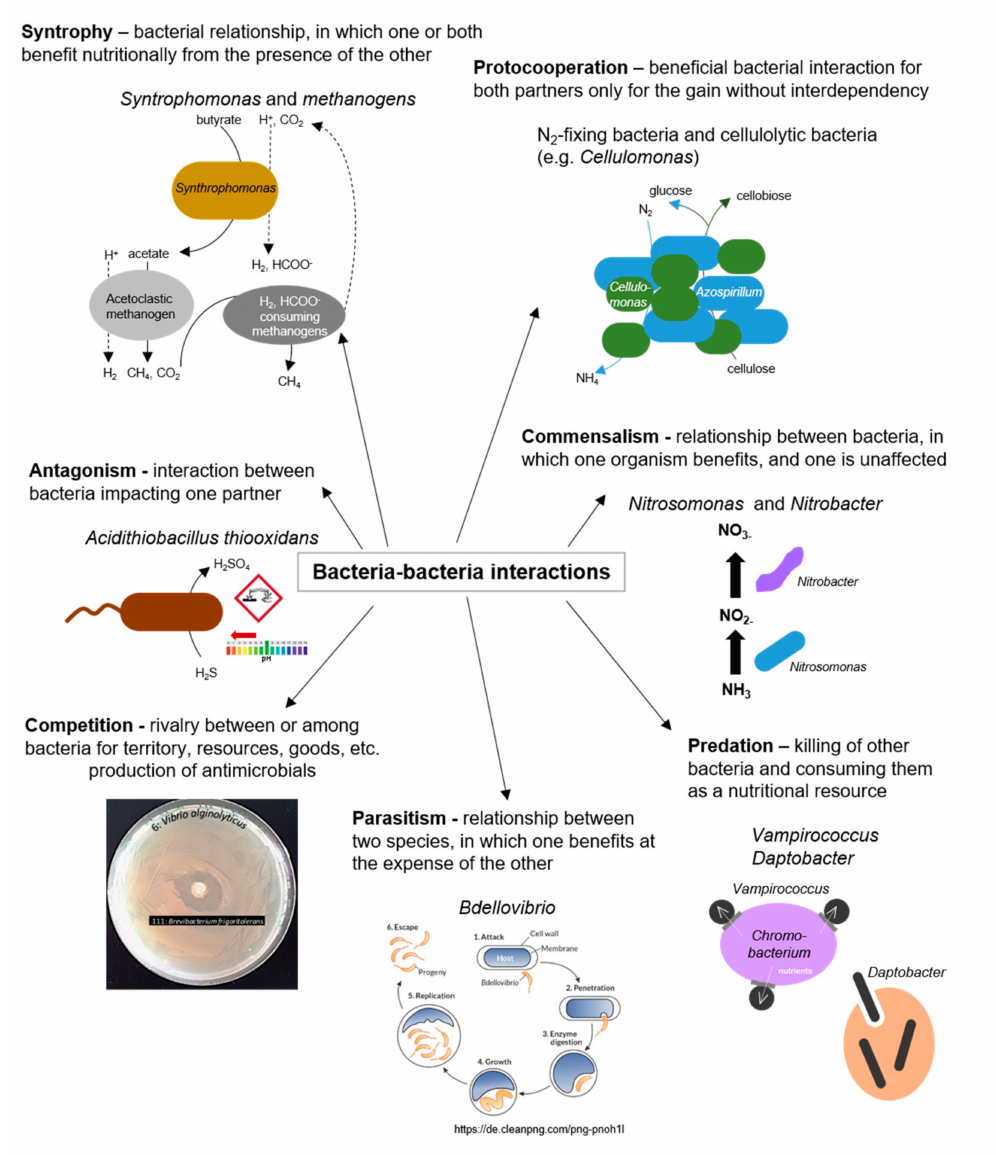
Figure 4. Bacteria–bacteria interactions; examples of positive and negative interactions among bacterial